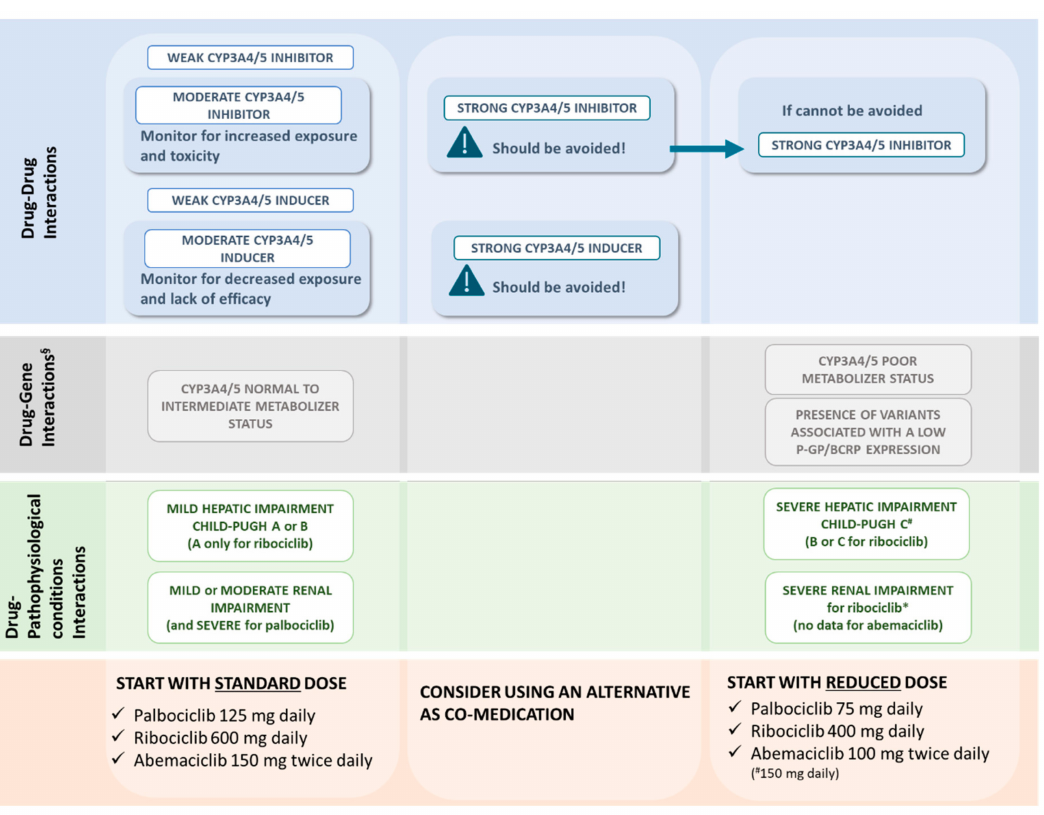
Figure 2. Starting dose selection of palbociclib, ribociclib and abemaciclib, according to DDIs, DGIs or interactions with pathophysiological conditions. No studies have been performed in hemodialyzed patients for all the three CDKis. * In patients with severe renal impairment, treated with ribociclib, the starting dose which is approved by EMA is 400 mg / daily vs. 200 mg / daily by FDA. # The suggested reduced starting dose for abemaciclib is 150 mg daily. § No evidences available and no dosing is